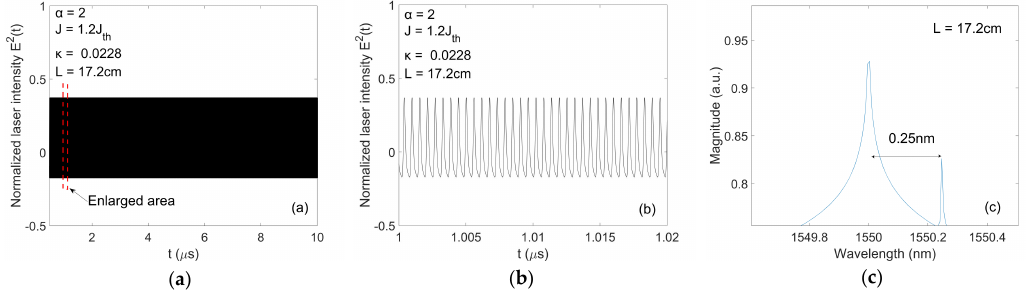
Figure 7. ( a ) LD operates at P1 state; ( b ) Enlargement of boxed area in ( a ); ( c ) Optical spectrum of laser light with two frequency